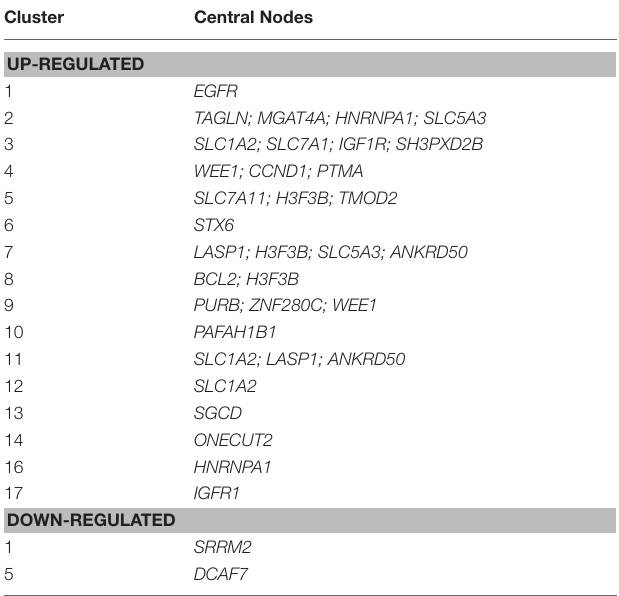
TABLE 6 | List of selected clusters of genes targeted by four or more up- or down-regulated miRNAs suitable for GO enrichment analysis. Cluster Central